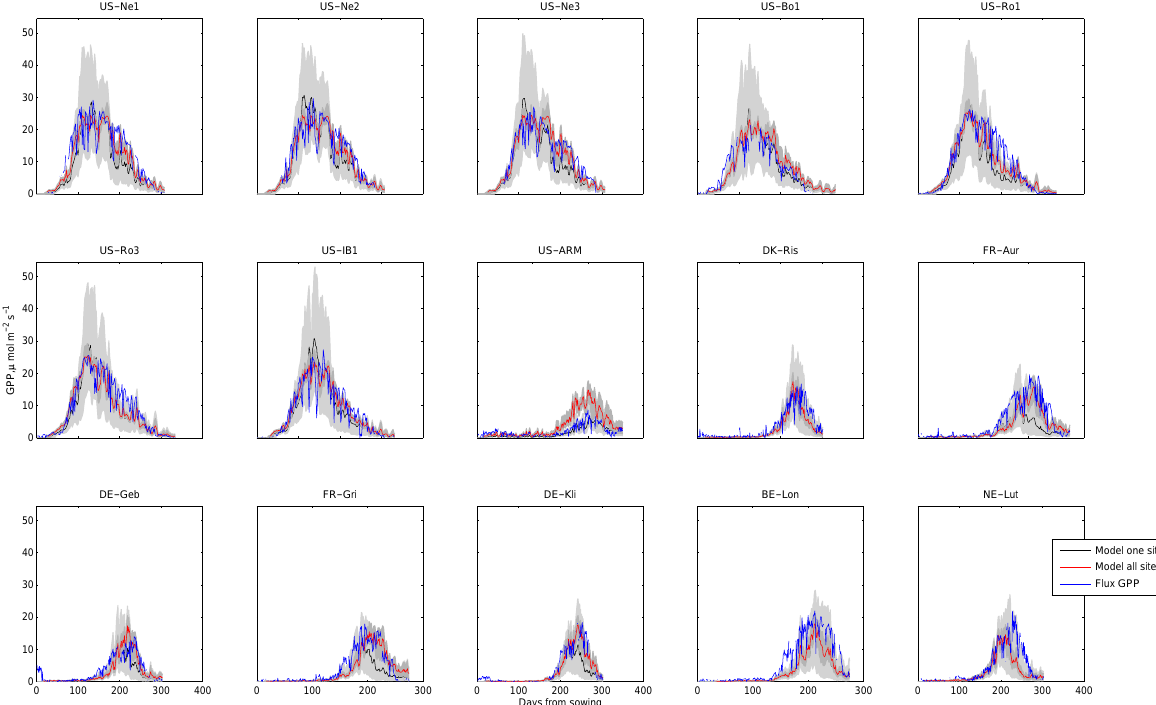
Figure A1. Gross primary production predictions for 1 year for all sites fitted using all available data at each individual site and at all sites together. Grey shaded areas represent 95% confidence intervals drawn from the posterior distribution.